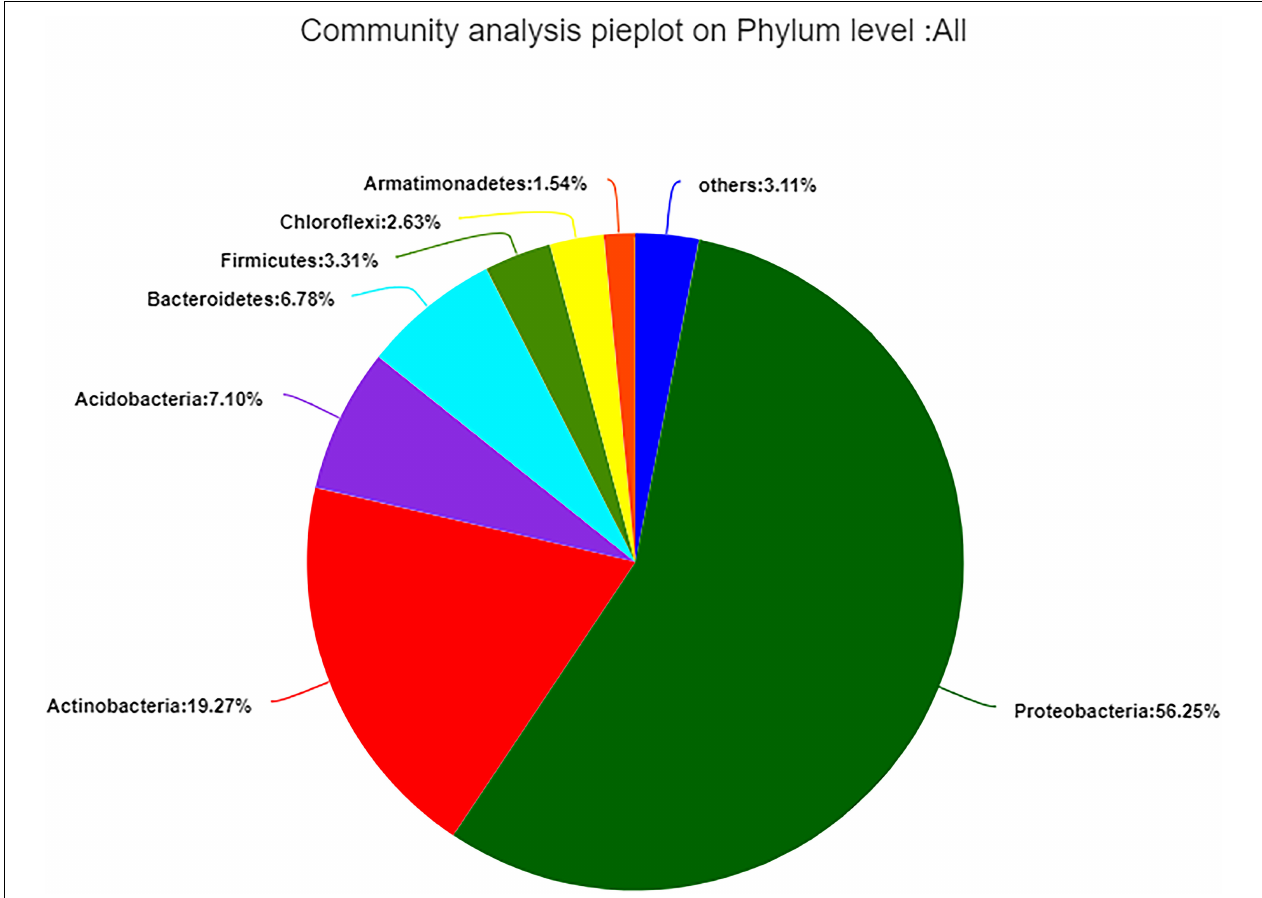
FIGURE 3 | Composition and relative abundance of endophytic bacterial in different samples on phylum level. Phyla making up less than 1% of total composition in samples were classified as “other.”